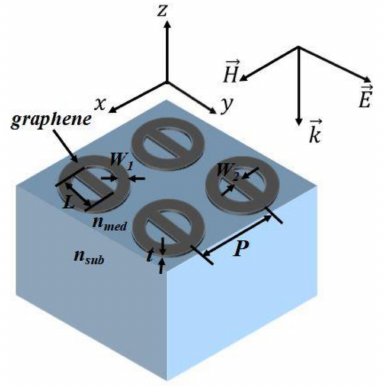
Figure 1. The schematic design of the geometry is as follows: nanoring-strip graphene arrays